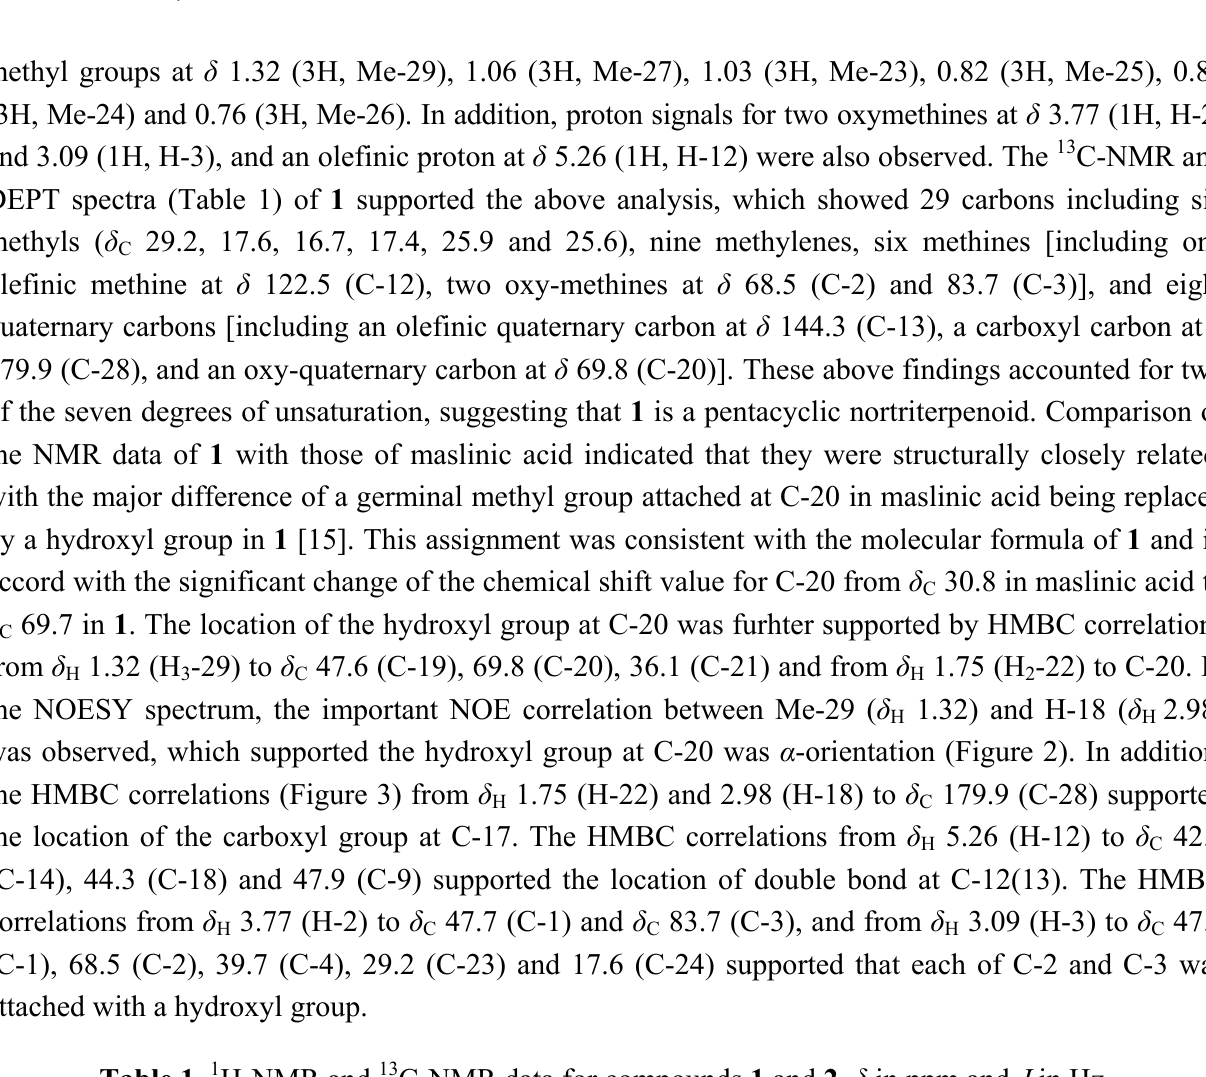
Table 1. 1 H-NMR and 13 C-NMR data for compounds 1 and 2 , δ in ppm and J in